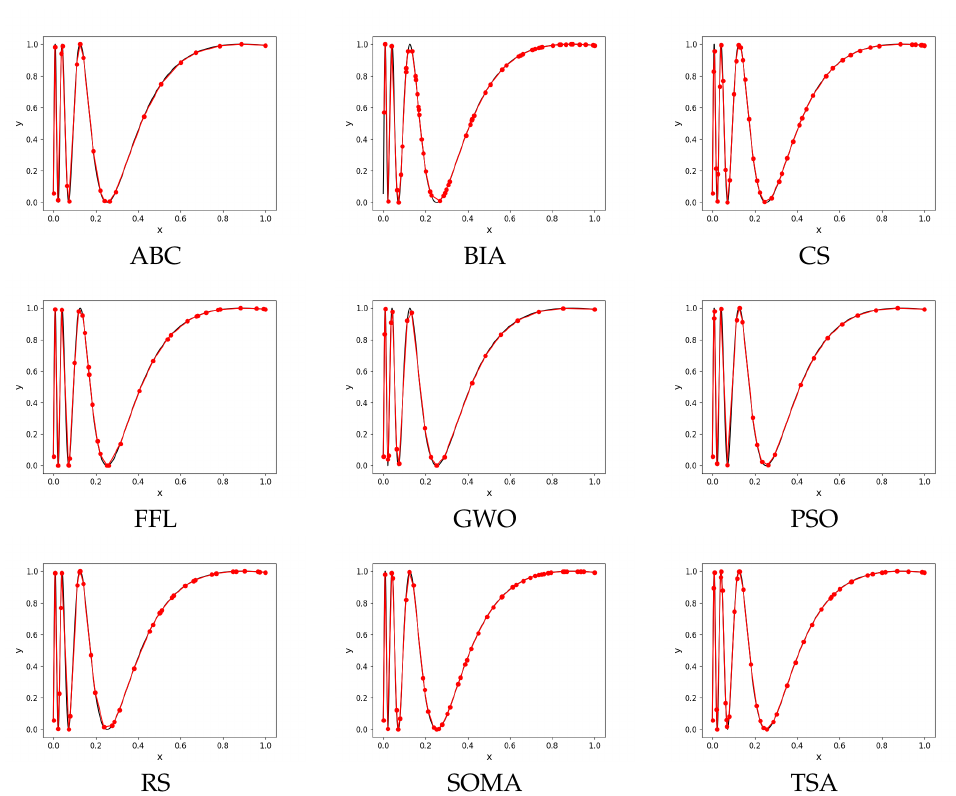
Figure 7. Graphs of algorithms with a value of maxFES =